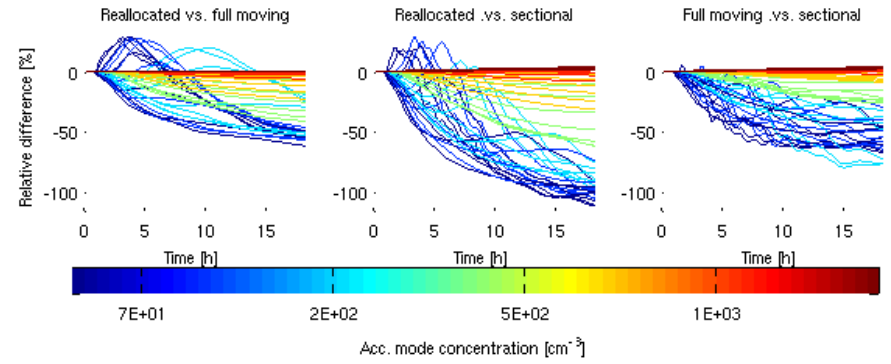
Figure 13: The relative differences of the CDNC between the three different models. Similar phenomenons can been seen on lower accumulation mode number concentrations as in previous chapters.